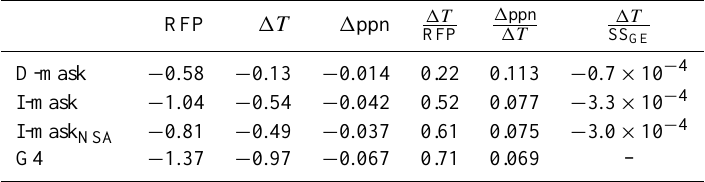
Table 2. RFPs (Wm − 2 ), global-mean changes in near-surface temperature (K) and precipitation rate (mmday − 1 ), the efficiency per unit RFP of the change in temperature (K/Wm − 2 ), the change in precipitation per unit change in temperature (mmday − 1 /K) and the change in near-surface temperature per unit emission rate of geoengineered sea-salt (K/kgs − 1 ) for the three sea-spray emission patterns and GeoMIP G4. RFP